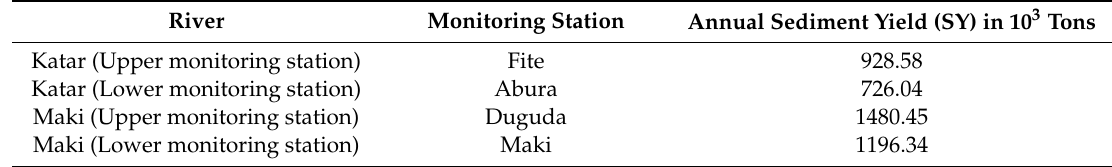
Table 3. Overview of suspended sediment discharges from four gauged catchments in the Lake Ziway basin. Table 3. Suspended sediment discharges from four gauged catchments in Lake Ziway.